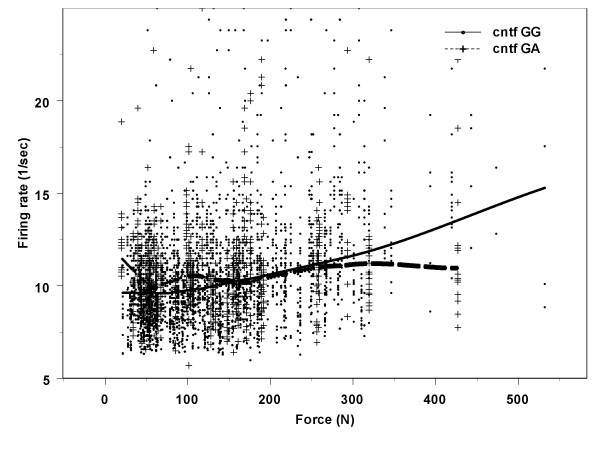
Relationship between knee extension force and mean motor unit firing rate (mFR) for CNTF GG and GA genotypes. Data represent individual measurements with a loess regression line for each genotype. Statistical analyses are given in Table 3.